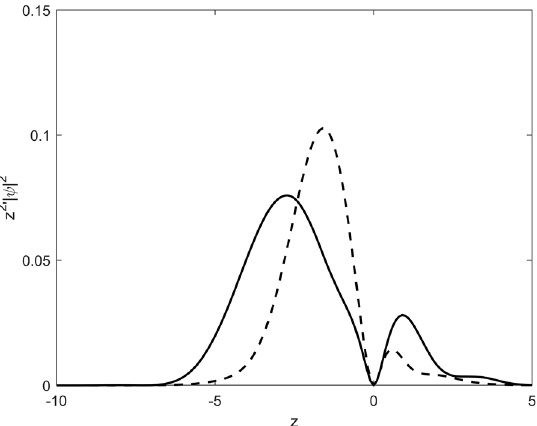
Figure 4. Electron density along the z-axis. Full curve: after passage of a half cycle pulse, dashed curve: after one full cycle Field parameters: E ( t )